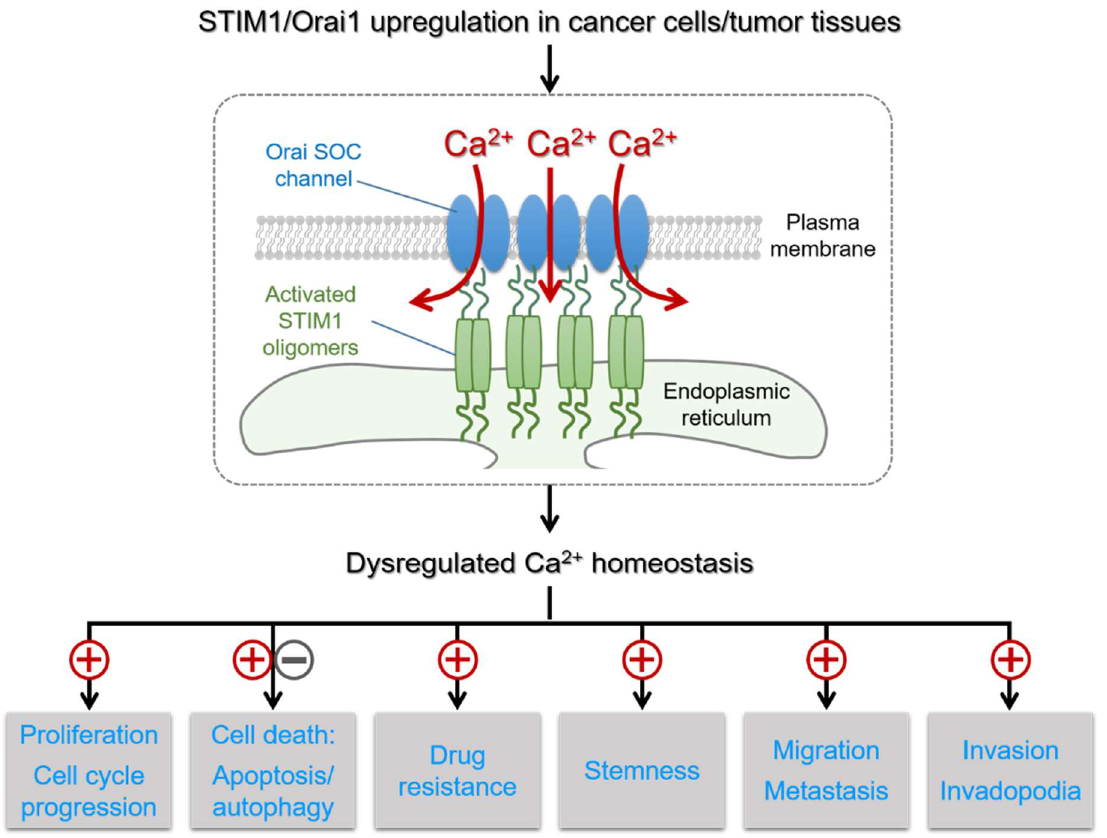
Figure 2. The active STIM1-Orai1 SOC channel complex and its important role in cancer. The effects of the STIM1/Orai1-mediated Ca 2+ influx on several cancer hallmarks and cancer-related signaling pathways are indicated with ⊕ for promoting effects and ㊀ for inhibiting effects.